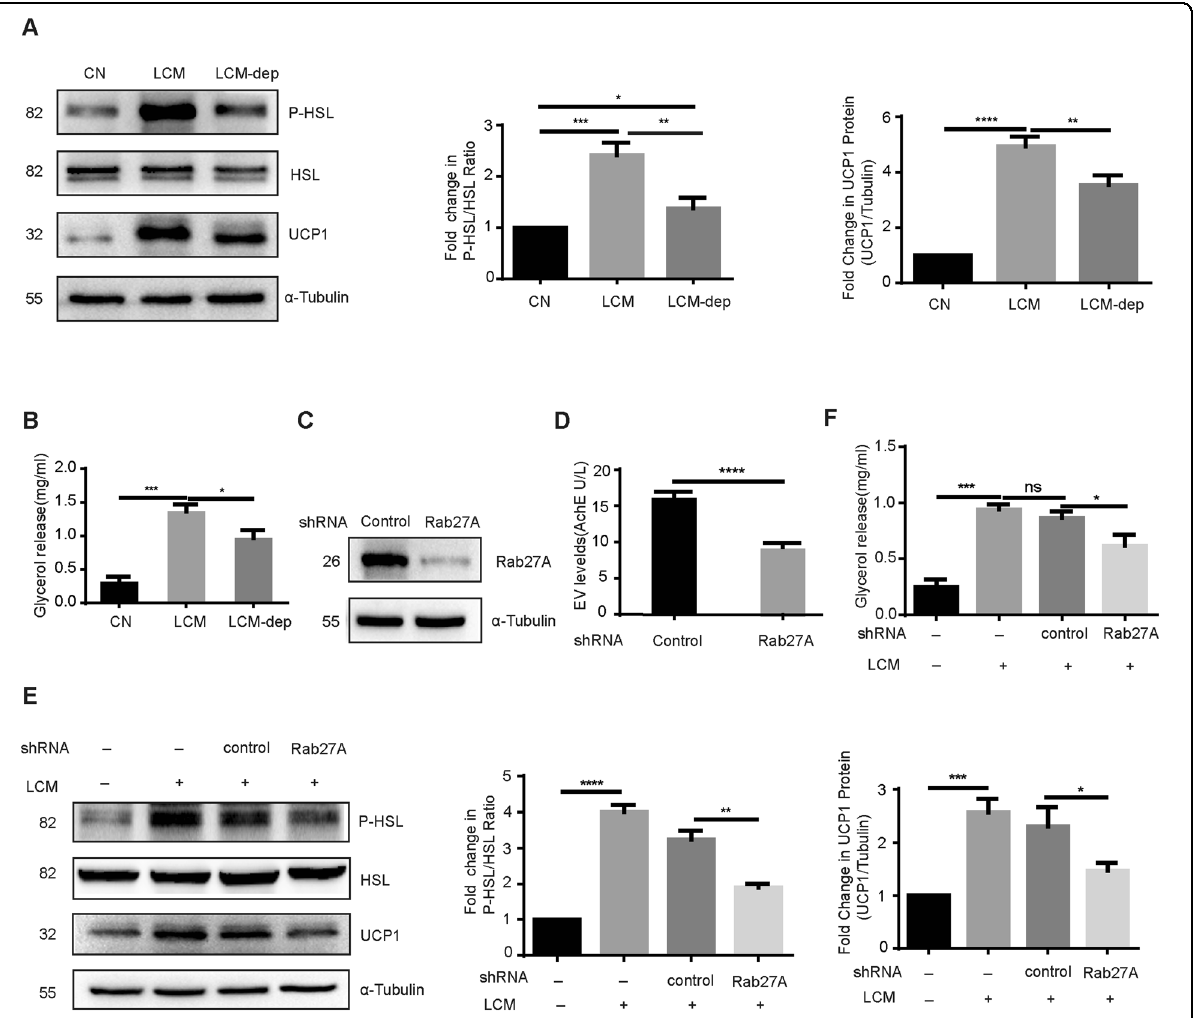
Fig. 2 LLC-EVs have a lipolytic action in 3T3-L1 adipocytes. A Western blotting showing the relative level of phospho-HSL: HSL and UCP1 in 3T3- L1 adipocytes. Data ( n = 3) were analyzed by analysis of variance (ANOVA). B Glycerol levels in the supernatants of 3T3-L1 adipocytes incubated with LCM or LCM-dep. Data ( n = 3) were analyzed by analysis of variance (ANOVA). C Western blotting showing the level of Rab27A in LLC cells. D AchE levels in supernatants of LLC cell transfected with shRNA-Rab27A or control lentivirus vector. Data ( n = 4) were analyzed by analysis of variance (ANOVA). E Western blotting showing the relative level of phospho-HSL: HSL and UCP1 in 3T3-L1 adipocytes incubated with or without LCM, and LCM (Rab27A shRNA or control shRNA). Data ( n = 8) were analyzed by analysis of variance (ANOVA). F Glycerol levels in the supernatants of 3T3-L1 adipocytes incubated with or without LCM, and LCM (Rab27A shRNA or control shRNA). Data ( n = 3) were analyzed by analysis of variance (ANOVA). * P < 0.05, ** P < 0.01, *** P < 0.001, **** P < 0.0001, ns: not signi fi